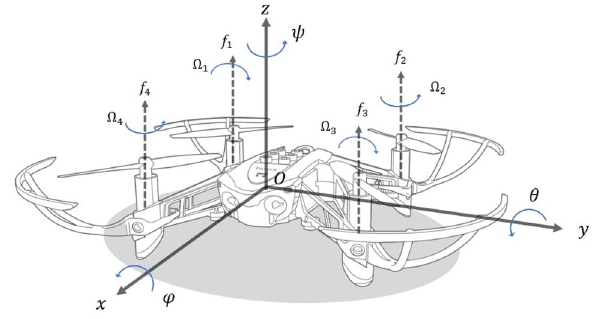
Figure 1. Body fixed and earth reference frame of a 6-DOF